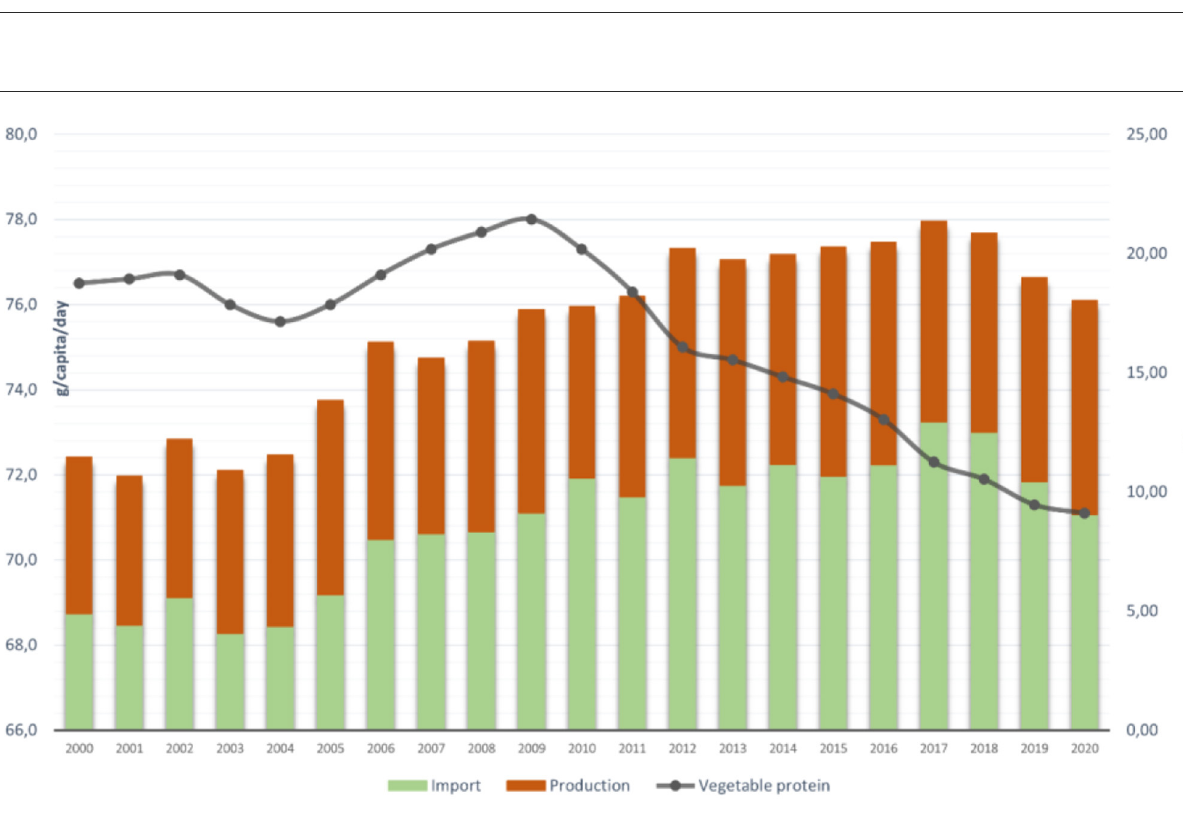
FIGURE8 Wheat balance and its effect on plant protein consumption in Egypt. Source: Food and Agriculture Organization